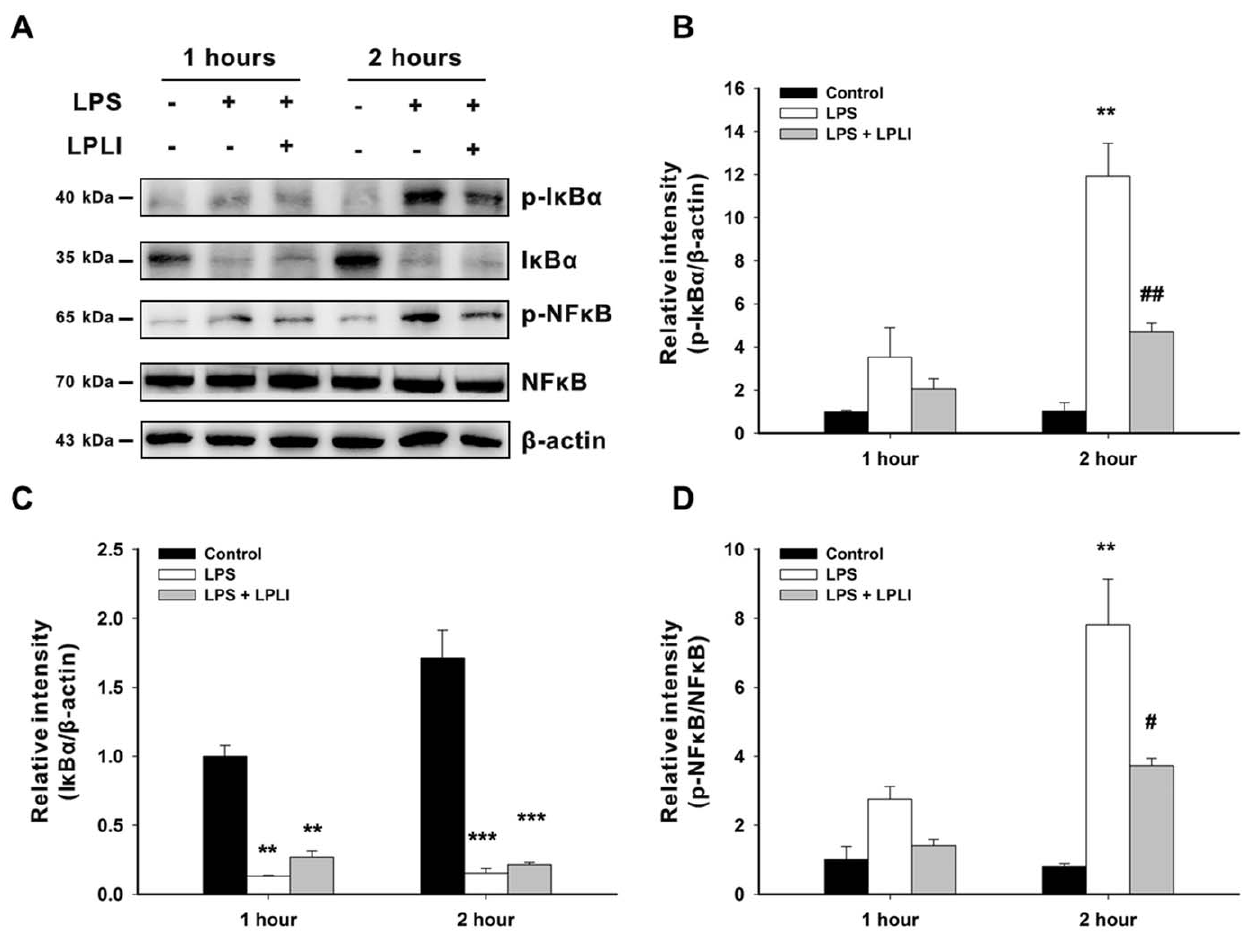
Figure 4. LPLI decreases I k B a degradation and NF k B activation. ( A ) hADSCs were treated with or without LPS (50 ng/ml), immediately followed by LPLI (8 J/cm 2 ). After 1 hour and 2 hours, the protein expression of p-I k B a , I k B a , p-NF k B and NF k B was determined using Western blot analysis, and b -actin served as loading control. The blots were quantified, and the results were expressed as ratios compared to LPS (0 ng/ml) at 1 hour, which was defined as 1. ( B ) p-I k B a vs. b -actin. ( C ) I k B a vs. b -actin. ( D ) p-NF k B vs. NF k B. The data are shown as the mean 6 SD of 3 independent experiments. The following statistical levels were applied: **p , 0.01 and ***p , 0.001 compared to the control and # p , 0.05 and ## p , 0.01 compared to LPS (50